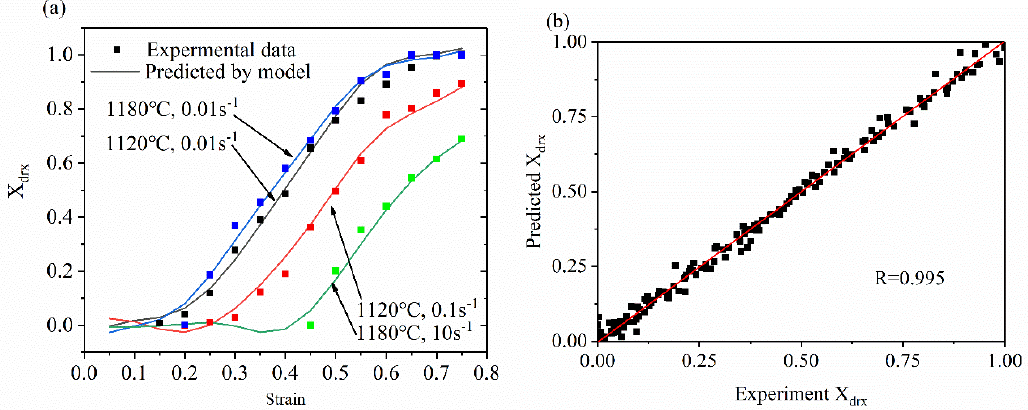
Figure 6. ( a ) Partial X drx predicted values and experimental values ( b ) and X drx predicted values and experimental values correlation.